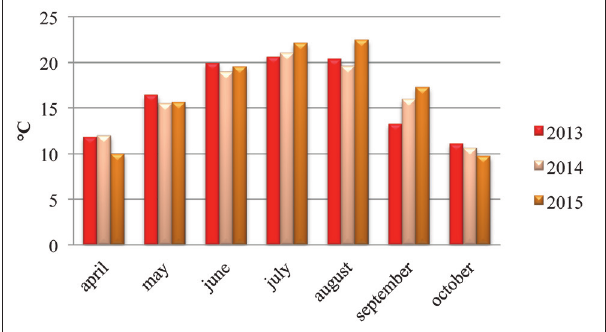
Figure 1 : Mean temperatures per month during the vegetation period (Nyírbátor,